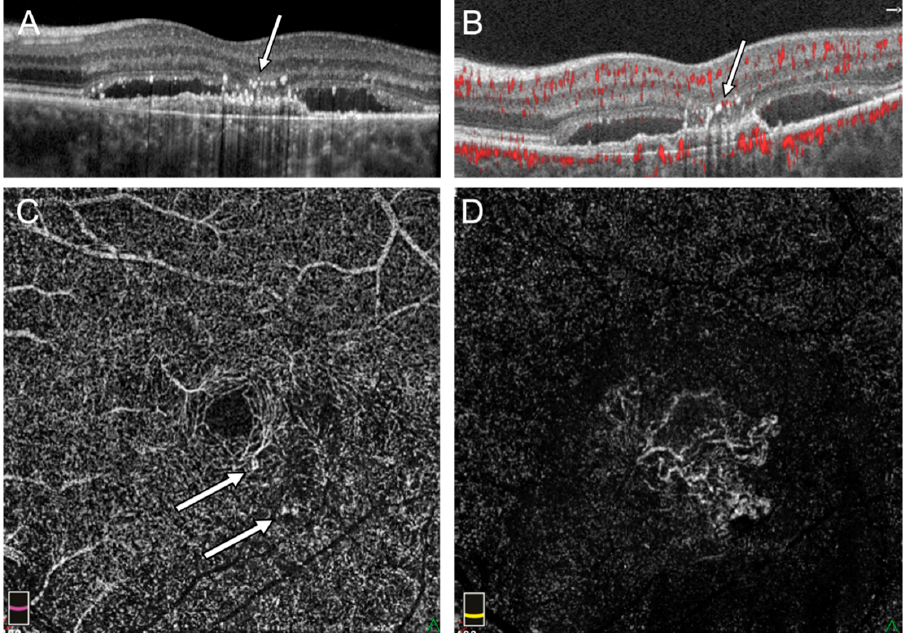
Figure 3. Flow signal in outer retina in the left eye with subretinal fluid and no sign of intraretinal cysts: ( A ) Hyperreflective foci above fibrovascular PED and fluid under sensory retina in SDOCT cross section (arrow), ( B ) pathologic flow adjacent to hyperreflective foci in OCTA (arrow), ( C ) en face OCTA on the level of DVP shows focal points of increased flow (arrow), ( D ) the external retina with flow of subfoveal MNV in en face OCTA.